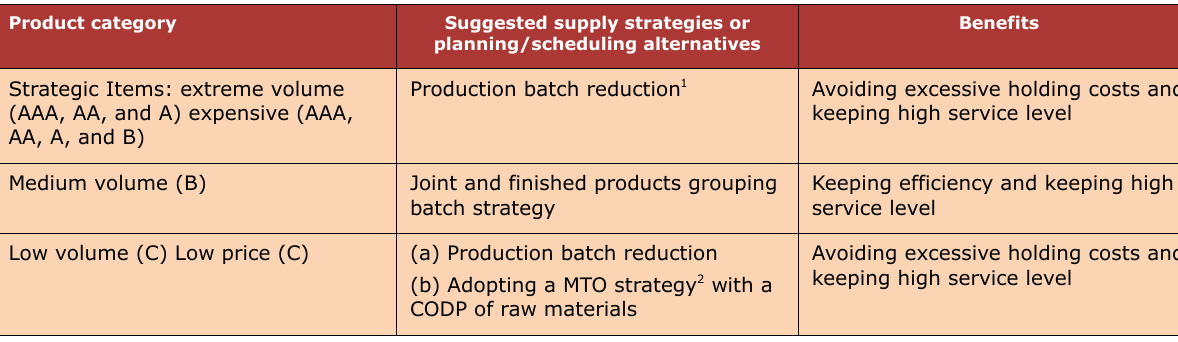
Table 1. Strategies and benefits for each finish product category